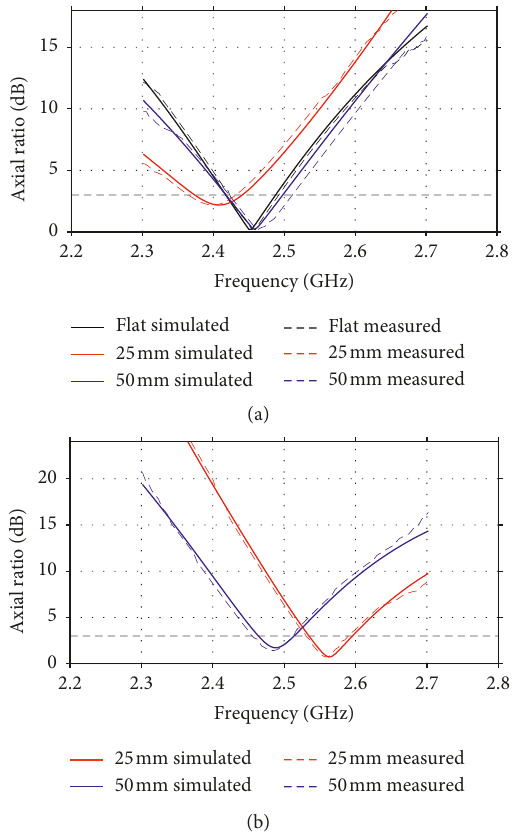
Figure 9: Simulated and measured AR: (a) x -axis bending and (b) y -axis